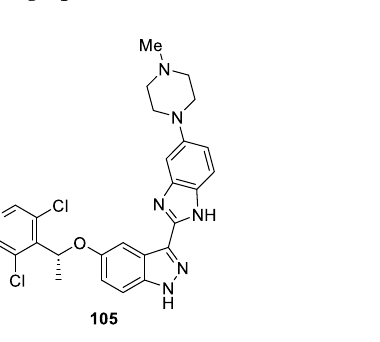
Figure 17. Chemical structure of 3-(5 ′ -Substituted) – Benzimidazole-5-(1-(3,5-dichloropyridin-4-yl) ethoxy)-1 H -indazole derivative 105 .